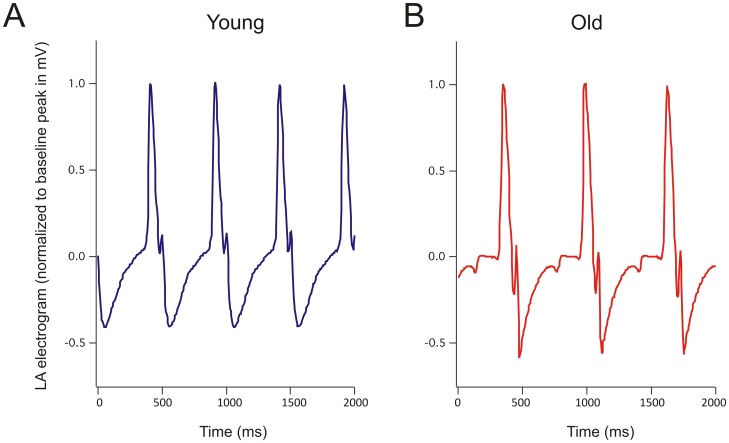
Atrial electrophysiology of young versus aging swine.A. Exemplar atrial electrogram recorded from a young female pig. B. Exemplar atrial electrogram recorded from an old female pig.